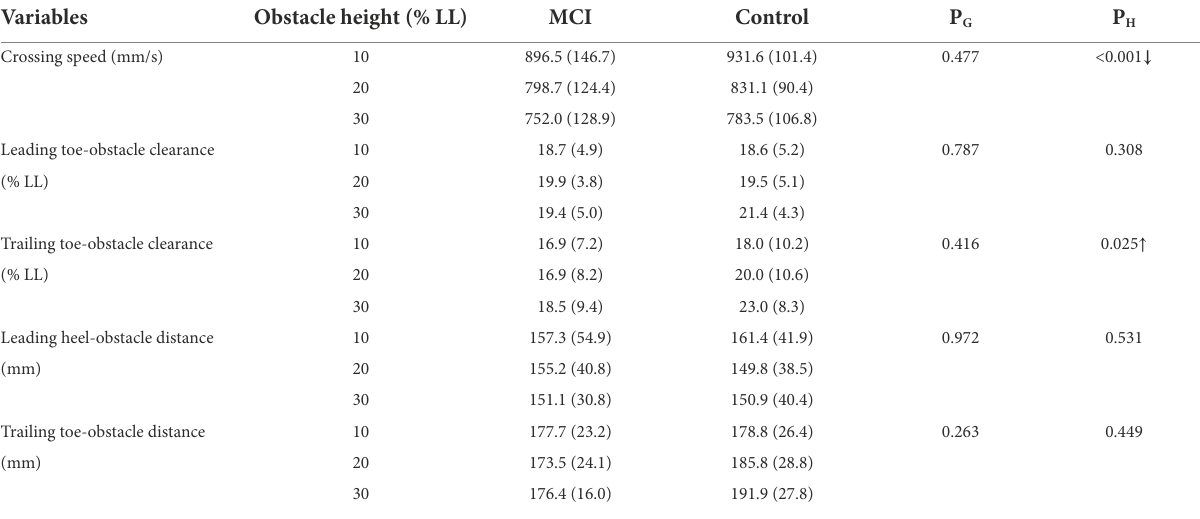
TABLE 2 Means (standard deviations) of the crossing speeds and end-point parameters for patients with mild cognitive impairment (MCI) and healthy controls (Control) when crossing obstacles of heights of 10, 20, and 30% of the subject’s leg length (LL).